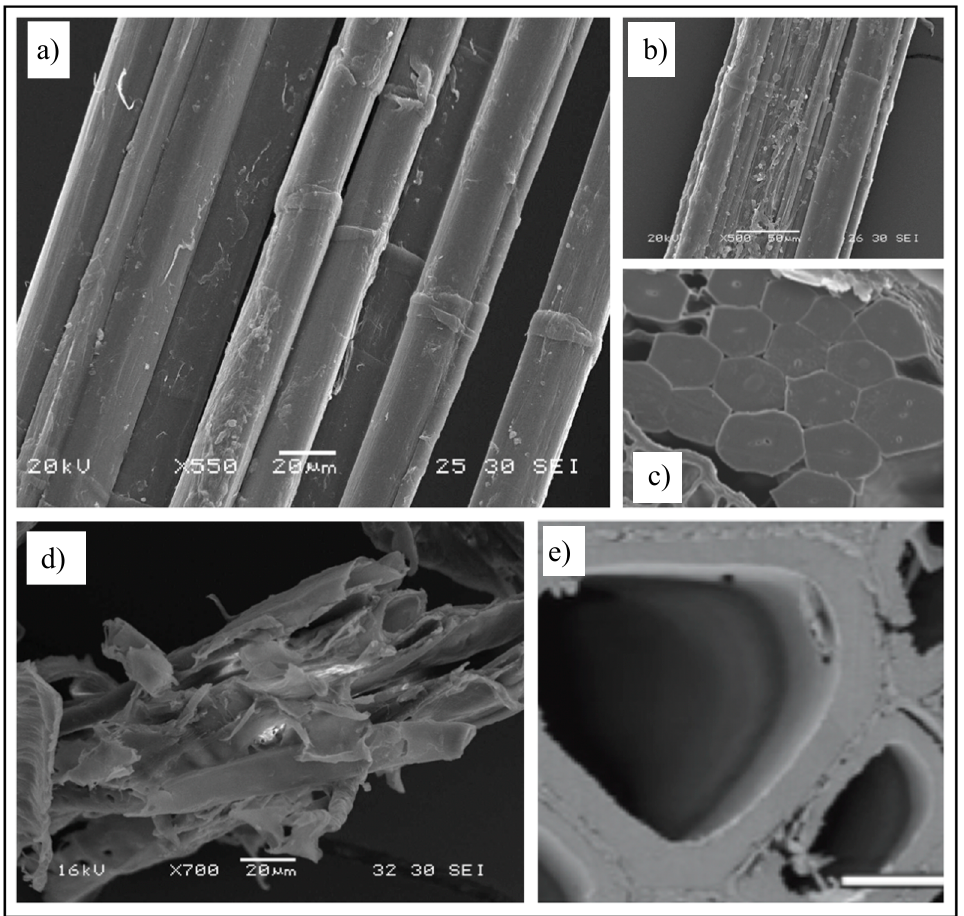
Figure 1. SEM images of plant fibres. High-quality ( a ) and poorly retted ( b ) flax fibres and in planta cross-section ( c ) of flax fibres. ( d , e ) Wood fibres. One can notice the difference in lumen sizes between flax and wood. The presence of kink bands in flax is also visible. Images by the author A.B.